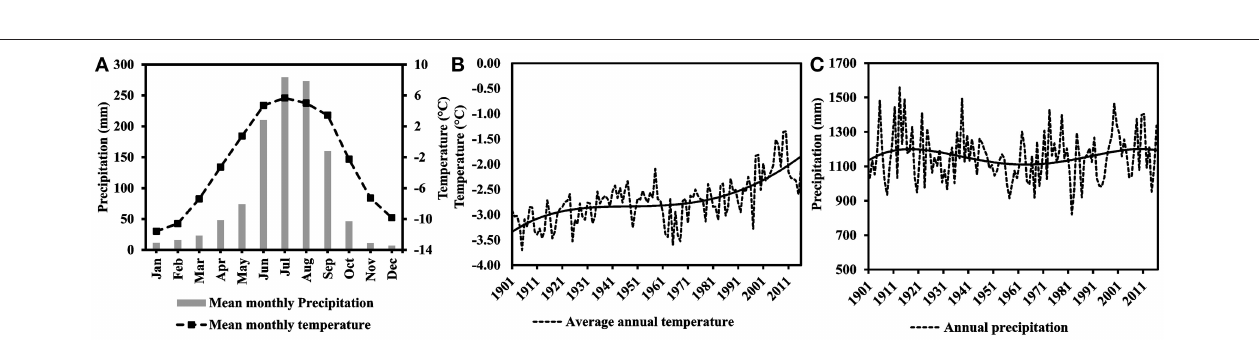
FIGURE 3 | Climate data for Sikkim Himalaya. Mean monthly temperature and precipitation from 1901 to 2016 (A) . Panels (B,C) show the average annual temperature and annual precipitation form 1901 to 2016, respectively [Date source: Climate Research Unit (CRU) Time Series (TS) Volume 4.01].